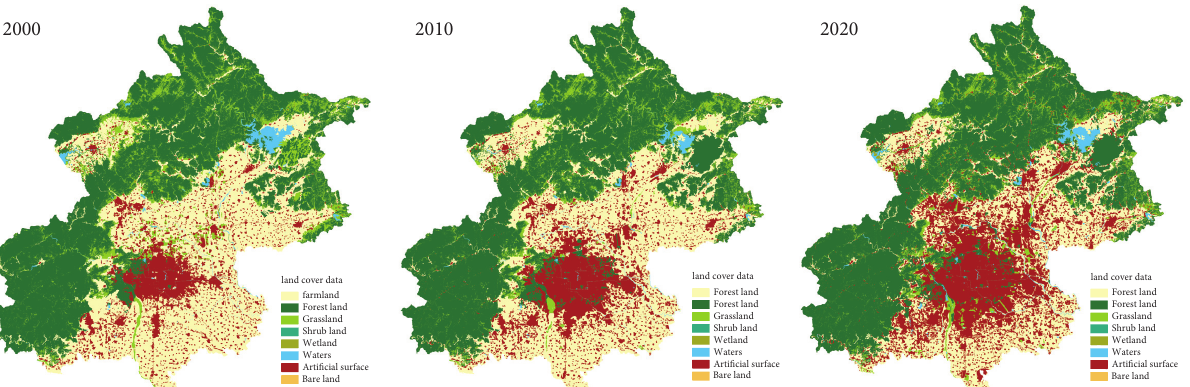
Figure 5: Land cover change of Beijing (2000–2020).